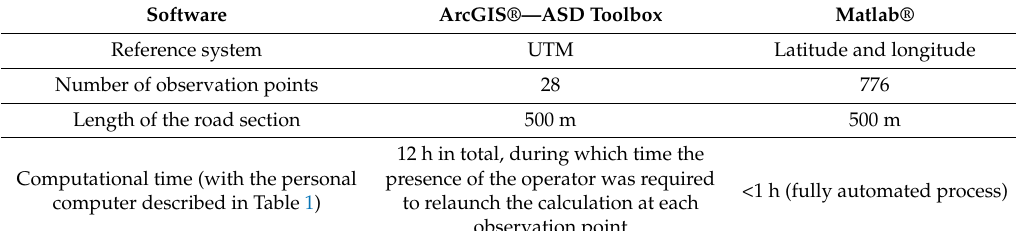
Figure 11. Convergence of a meridian (angle— γ —formed by the representation of the meridian with the north of the projection—i.e., vertical axis of the Cartesian reference system). Table 4. Comparison of ArcGIS® and Matlab® solutions.